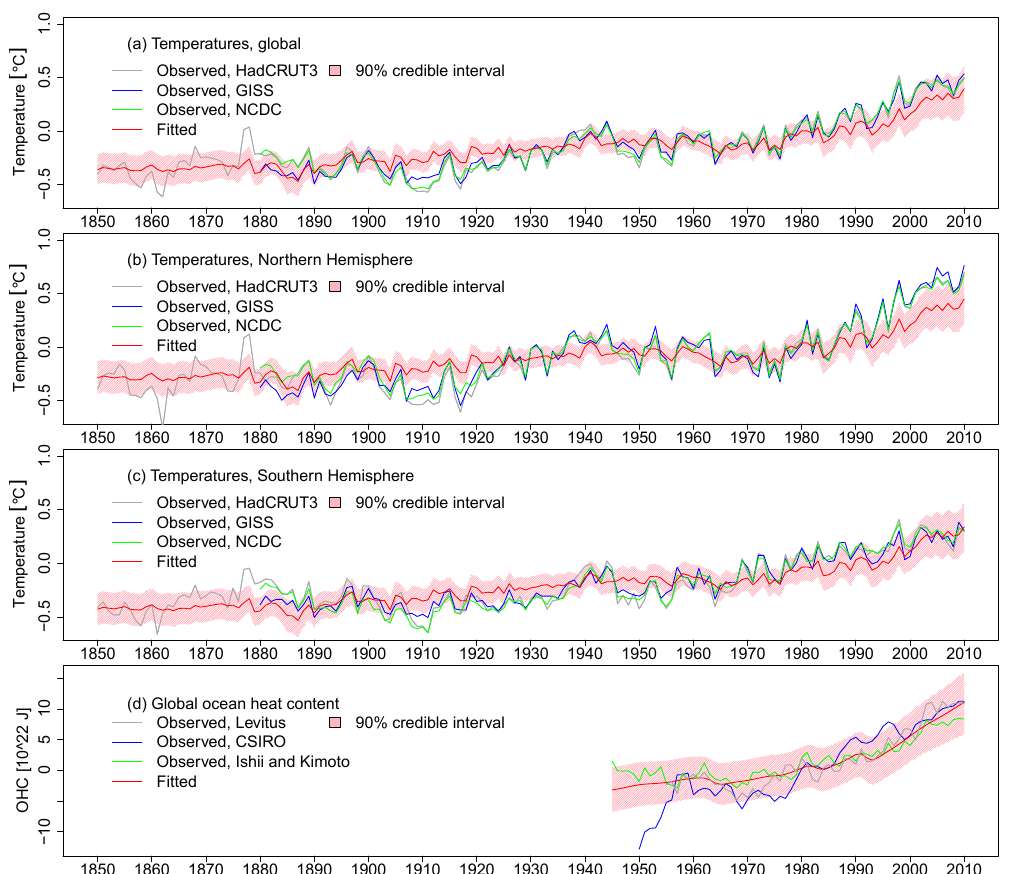
Fig. 3. Observed and fitted (posterior mean) values for the temperature series and the ocean heat content for the main analysis. The shaded areas show the 90% C.I. for the sum of the two first terms ( m t ( x 1750 : t , ECS, θ ) + β 1 e t ) on the right side of Eq.